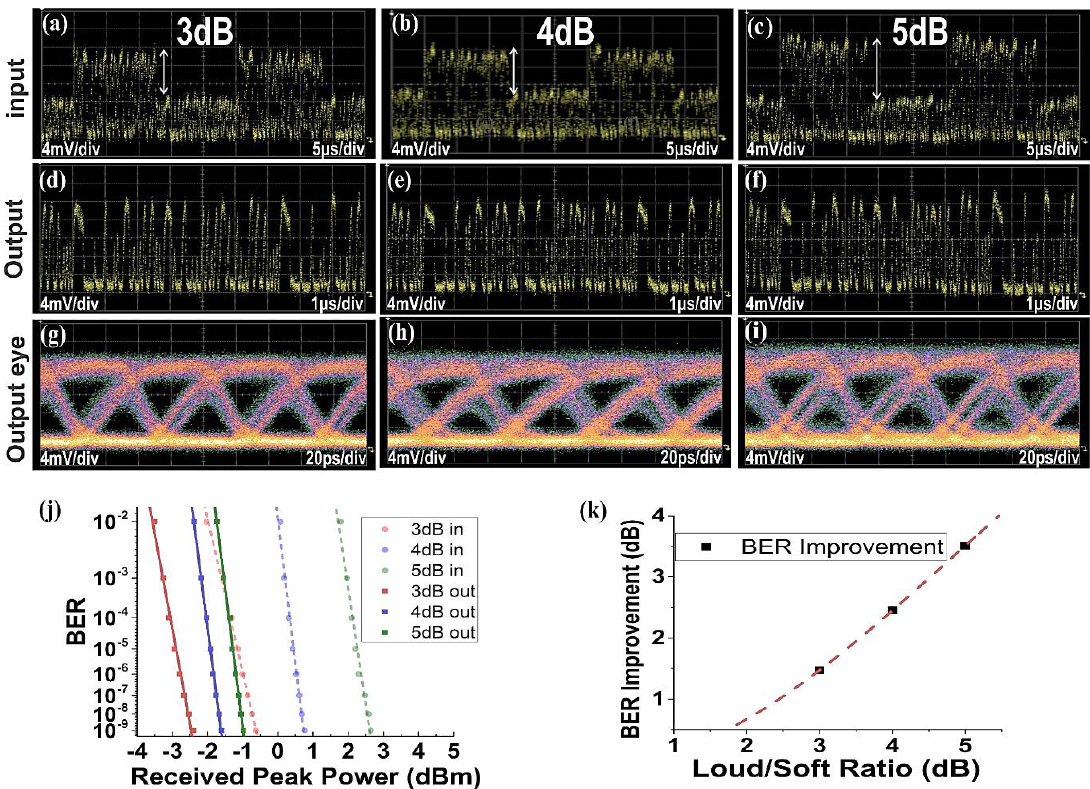
Figure 3. Experimental results for 20 Gb/s for 3 dB loud/soft ratio ( a ) input trace (2.5 μs/div), ( d ) output trace (1 μs/div), ( g ) output eye diagram (20 ps/div). For 4 dB ( b ) input trace, ( e ) output trace, ( h ) output eye diagram. For 5 dB ( c ) input trace, ( f ) output trace, ( i ) output eye diagram, ( j ) BER measurements for input and output signals and ( k ) BER improvement of input-output signals at different loud/soft